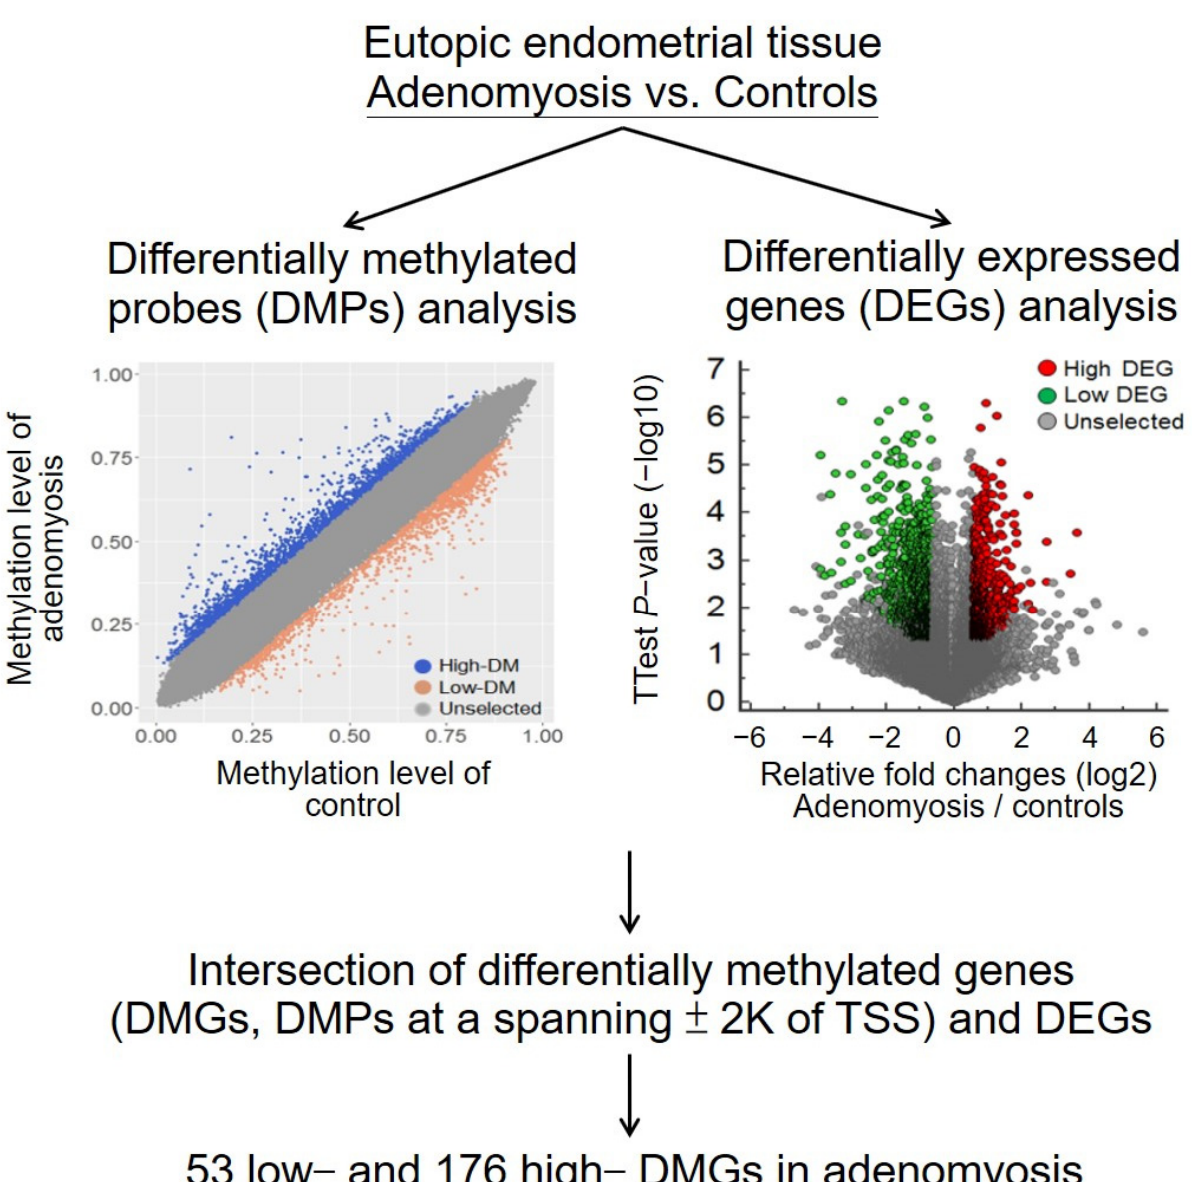
Figure 1. The methylomic profiles were constructed using a methylation 450K BeadChip. This BeadChip probe was used to detect the methylation level at a CpG site. According to the CpG loci related to the closest coding gene, major changes in the CpG site distribution were located at the promoter (including the 5 (cid:48) untranslated region (UTR)), gene body, and 3 (cid:48) UTR. The distributions of lowly methylated CpG sites in the adenomyosis group were 25%, 37%, and 29% at the promoter, gene body, and intergenic regions, respectively, whereas for highly methylated CpG sites, they were 30%, 35%, and 30%. The percentage at promoter regions was higher for highly methylated CpG sites than for lowly methylated CpG sites.